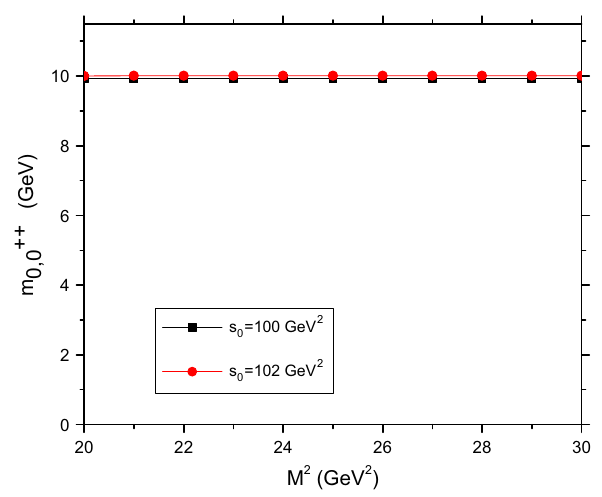
Fig. 12 Borelparameterdependenceof J PC = 0 ++ mesonmassfrom (cid:10) ( 0 ) μναβ for different s 0 values